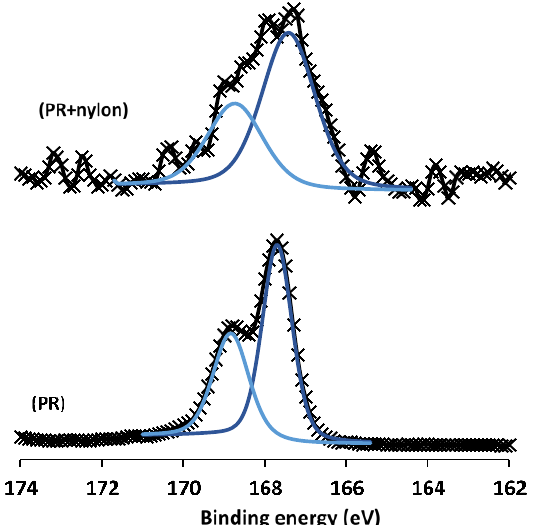
Figure 9. XPS of the S2p region of phenol red before (PR) and after filtration (phenol red + Nylon).